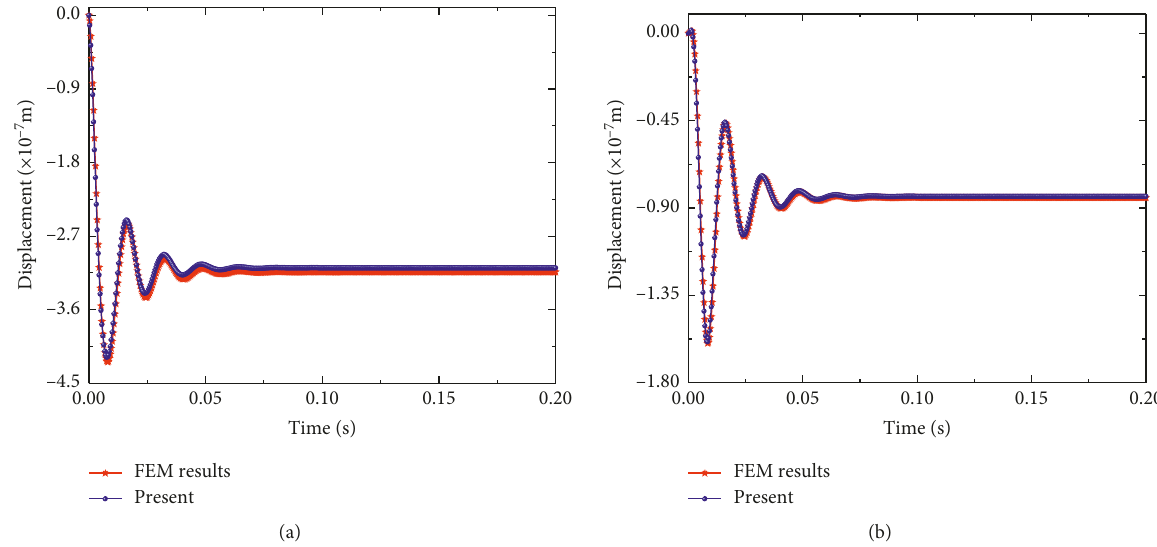
Figure 15: Comparison of transient responses for rectangular plate with one central x -wise beam and one central y -wise beam under local uniform pressure ( p w �− 1). (a) Point A (1m, 0.5 m). (b) Point B (0.5m,